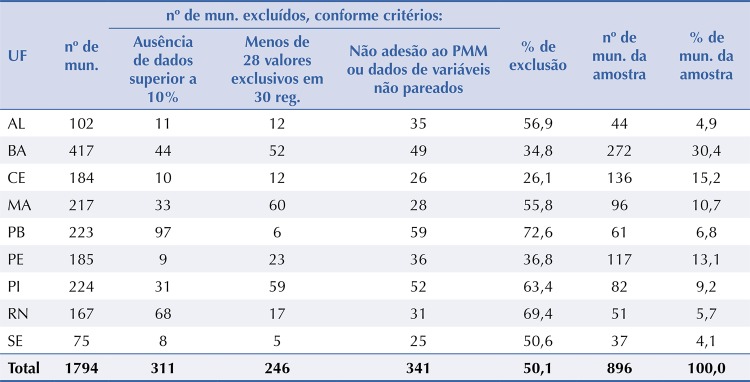
Conformação da amostra de municípios da pesquisa, segundo exclusões realizadas e distribuição por unidades federativas da região Nordeste.UF: Unidades da Federação; mun.: municípios; reg.: registros